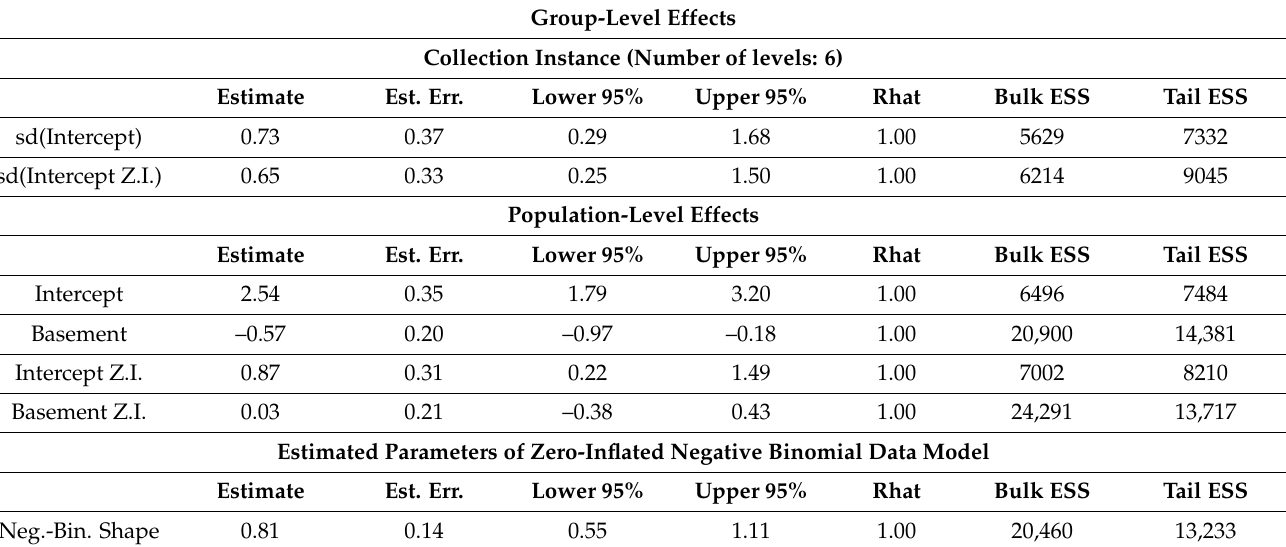
Table A2. Summary of Bayesian generalised linear model to assess the significance of basement versus non-basement ovitrap locations on mosquito eggs laid per felt. A model was fit for the mean of the negative-binomial distribution (log-link function) and simultaneously to the zero-inflation (Z.I.) probability (logit-link function). There were six collection events which were treated as group-level effects that contributed intercepts to the two models. Population-level effects were an intercept and the effect of the basement variable (i.e., whether the trap was placed in a basement) in both models. Columns for effects and estimated parameters are: posterior mean estimate (“Estimate”); standard error of the posterior mean (“Est. Err.”); lower limit of the 95% Bayesian credible interval (“Lower 95%”); upper limit of the 95% Bayesian credible interval (“Upper 95%”); Gelman-Rubin convergence statistic (“Rhat”); bulk effective sample size for the estimate (“Bulk ESS”); and the tail effective sample size of the estimate (“Tail ESS”).